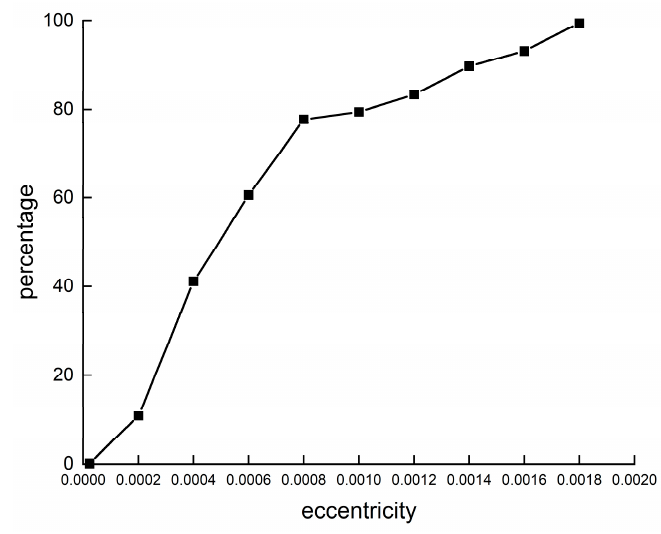
Figure 7. Distribution (percentage) of IOD eccentricity errors.